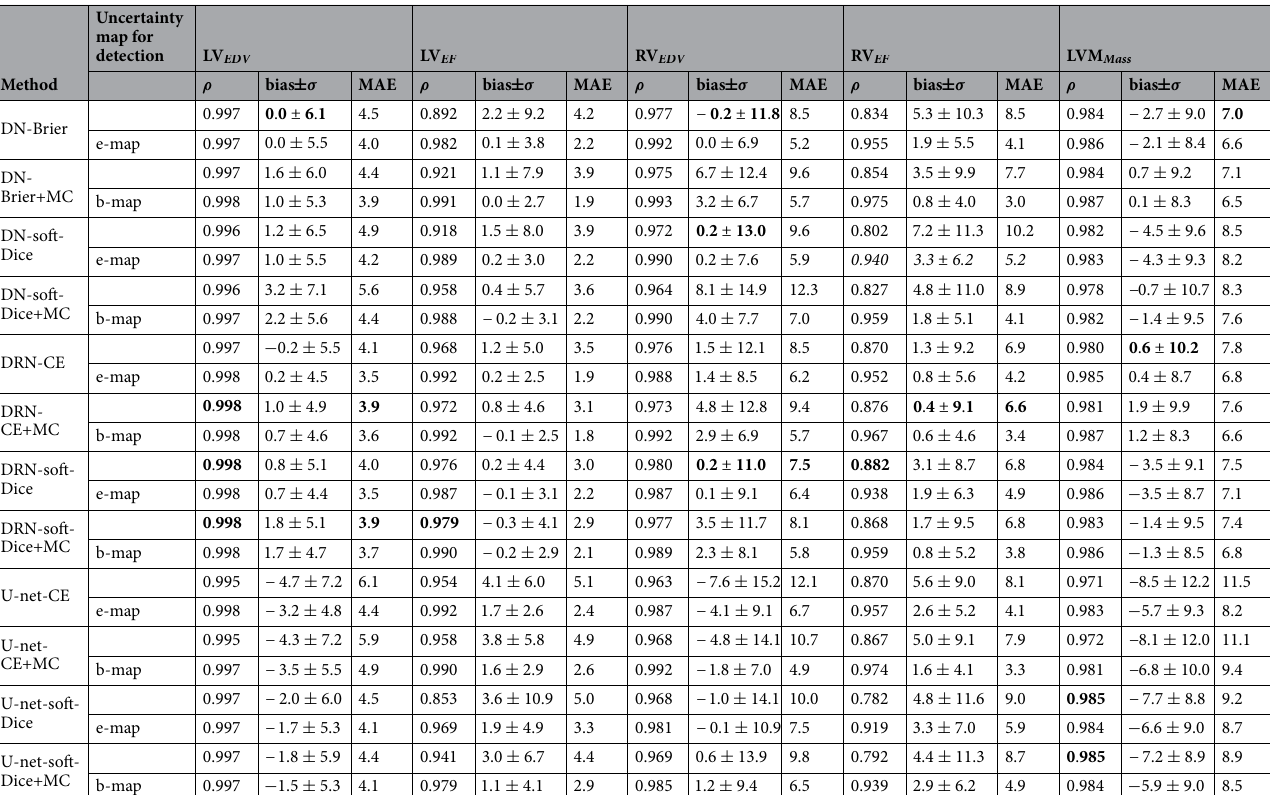
Table 2. Segmentation performance of different combination of model architectures, loss functions and evaluation modes (without or with MC dropout (MC) enabled during testing) in terms of clinical metrics: left ventricle (LV) end-diastolic volume (EDV); LV ejection fraction (EF); right ventricle (RV) EDV; RV ejection fraction; and LV myocardial mass. Quantitative results compare clinical metrics based on reference segmentations with (1) automatic segmentations and (2) simulated manual correction of automatic segmentations using spatial uncertainty maps. ρ denotes the Pearson correlation coefficient, bias denotes the mean difference between the two measurements (mean ± standard deviation) and MAE denotes the mean absolute error between the two measurements. Each combination comprises a block of two rows. A row in which column Uncertainty map for detection indicates e- or b-map shows results for the combined segmentation and detection approach. Numbers accentuated in bold are ranked first in the segmentation only task. Numbers in italics indicate statistical significant at 5% level w.r.t. the segmentation-only approach for the specific clinical